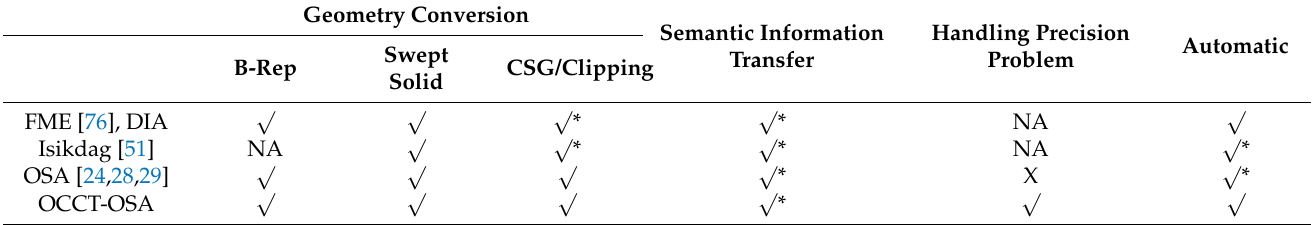
Table 11. Comparative summary for methods in IFC-to-shapefile